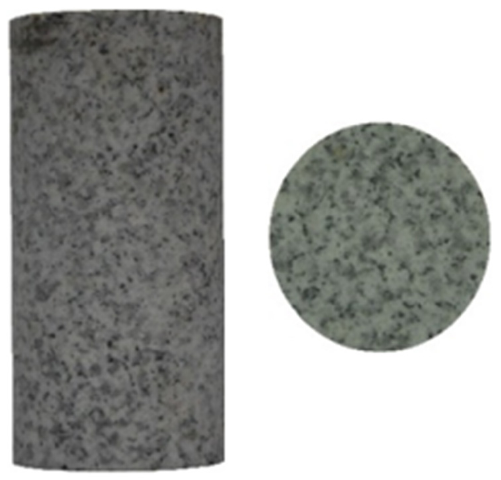
Figure 1. Granite Sample.